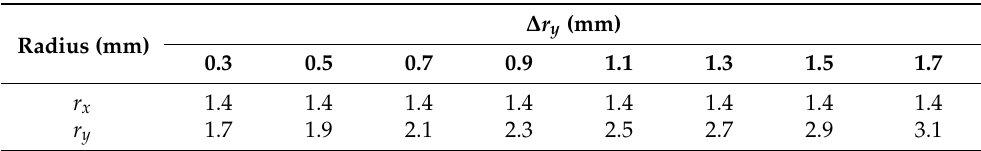
Table 1. The partial correspondences between ∆ r y and radius.